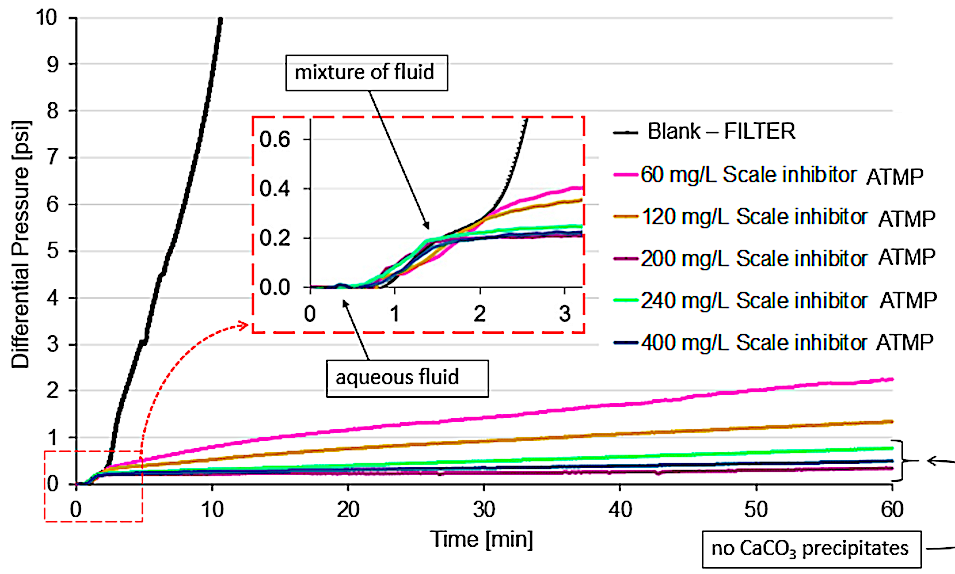
Figure 5. Scale inhibitor ATMP concentrations (0 mg / L, blank test; 60 mg / L; 120 mg / L; 200 mg / L; 240 mg / L; and 400 mg / L) used for MIC determination in a filter dynamic system at 80 ◦ C and 44